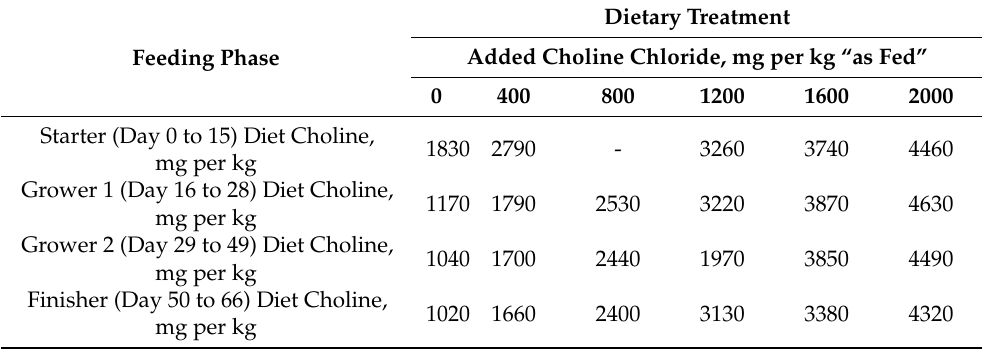
Table 2. Choline concentration (mg per kg) in broiler chicken diets with increasing additions of choline